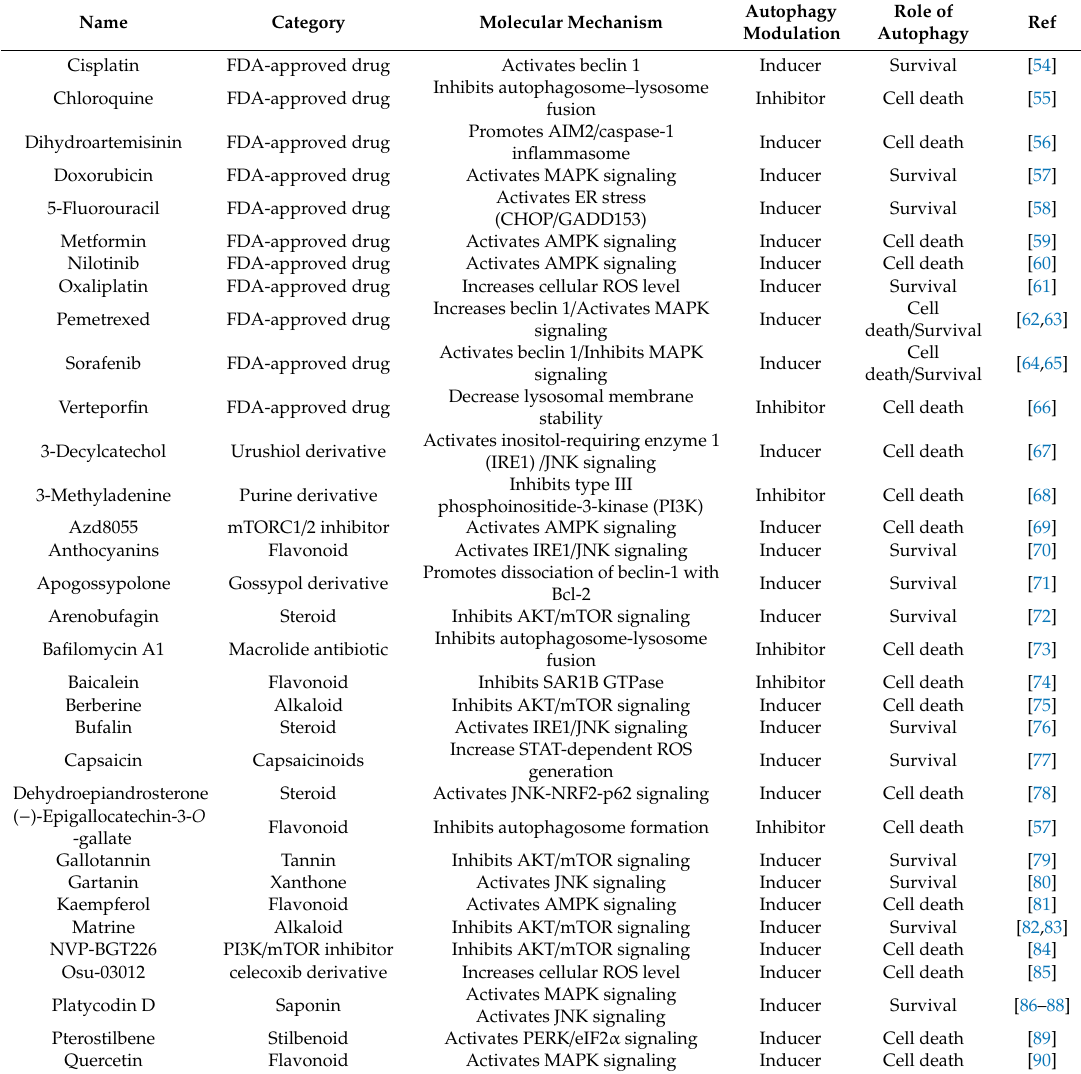
Table 1. Targeting autophagy using small molecules in